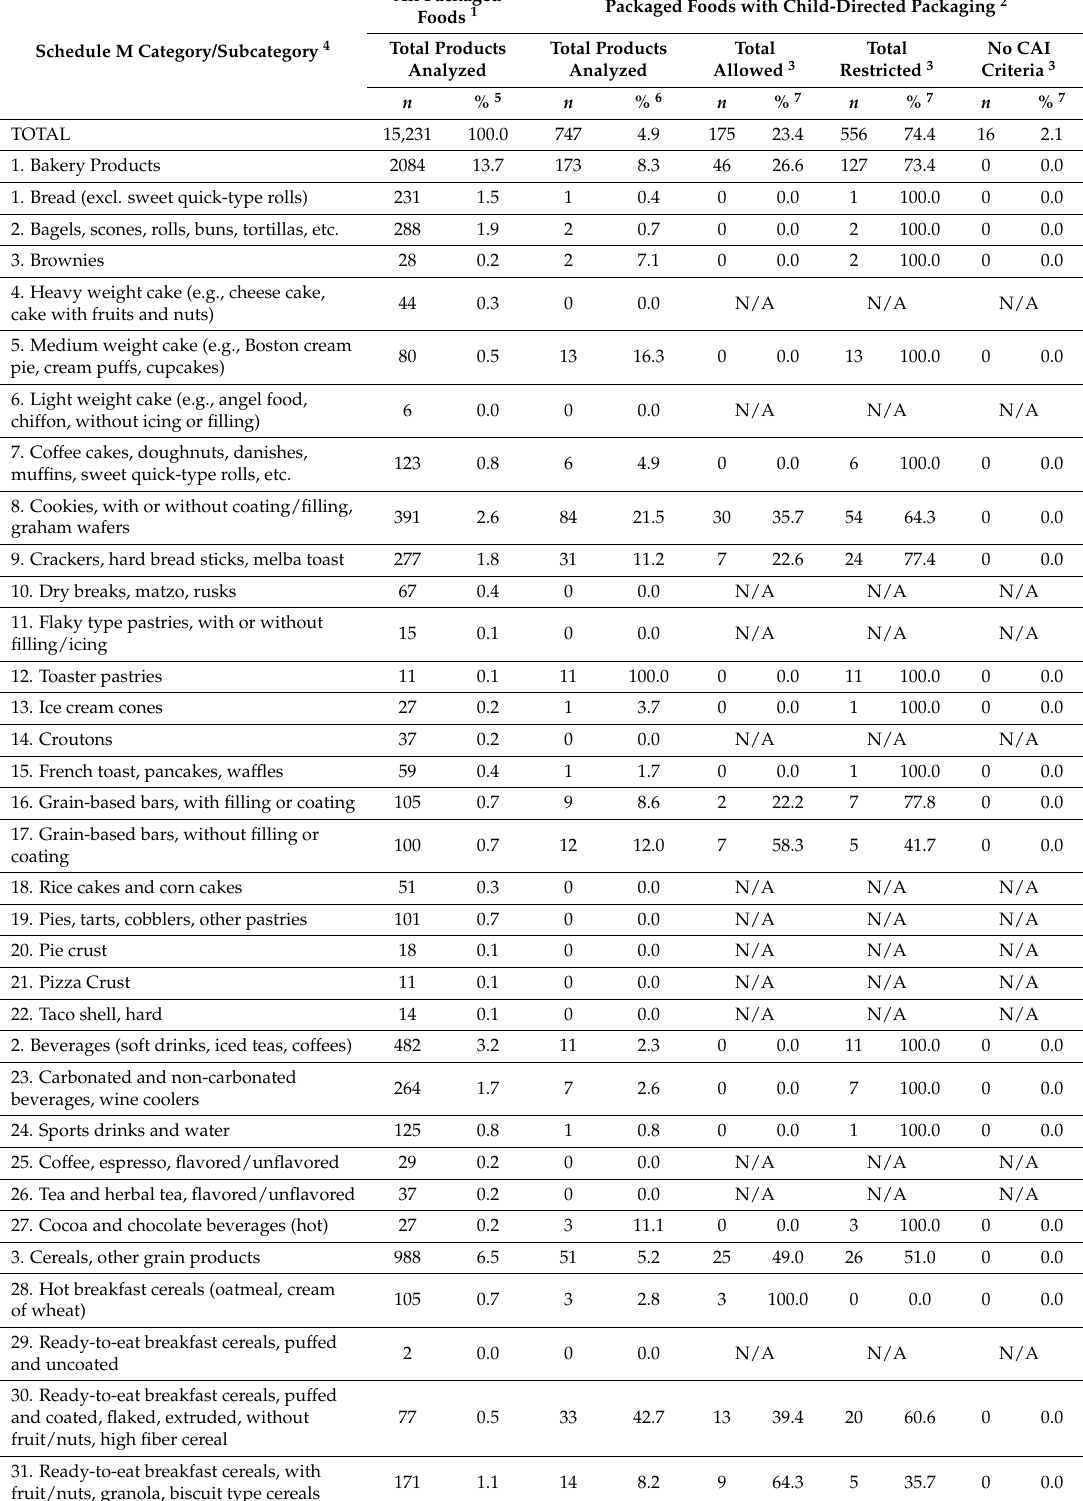
Table A2. Percentage of packaged food and beverage products 1 with child-directed packaging 2 that would be allowed to be advertised to children according to the CAI’s Uniform Nutrition Criteria 3 , presented by food subcategory 4